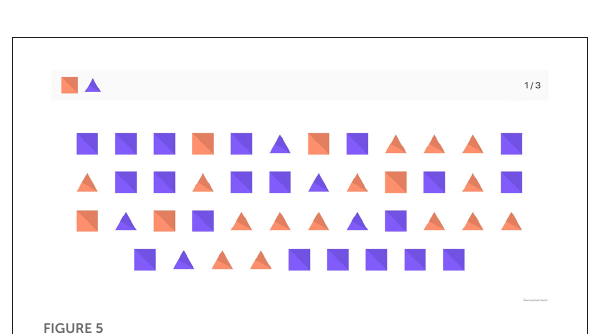
Task 5: circle tapping